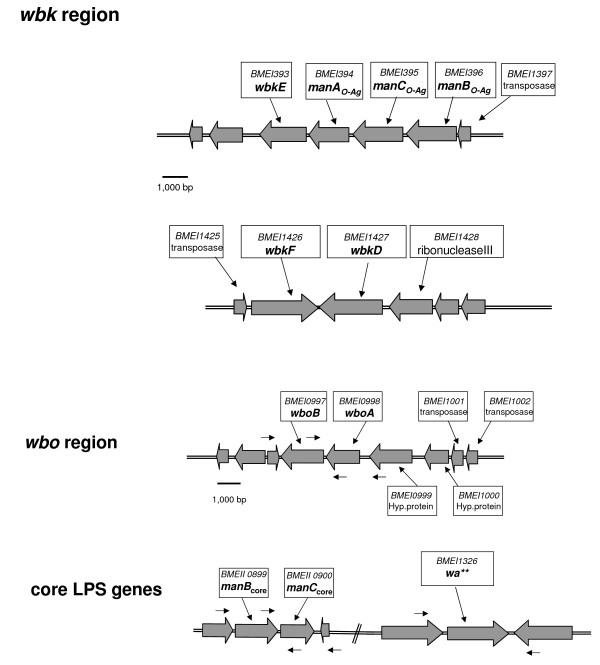
Regions and genes encoding LPS biosynthetic enzymes in B. melitensis 16 M Region wbk contains genes coding for: (i), enzymes necessary for N-formylperosamine synthesis (gmd, per, wbkC); (ii), two O-PS glycosyltransferase (wbkE, wbkA); (iii), the ABC transporter (wzm, wzt); (iv) the epimerase/dehydratase necessary for the synthesis of an N-acetylaminosugar (wbkD); and (v), the polyisoprenyl-phosphate N-acetylhexosamine-1-phosphate transferase enzyme that primes bactoprenol (wbkF). Genes manAO-Ag, manBO-Ag, manCO-Ag could be involved in the synthesis of mannose, the perosamine precursor. Restriction sites: A, AluI; AvI, AvaI; Av, AvaII; B, BglI; Bg, BglII; C, ClaI; E, EcoRI; EV, EcoRV; H, HindIII; Ha, HaeII; Hf, HinfI; P, PstI; Pv, PvuII; S, Sau3A; Sa, SaII; St, StyI.